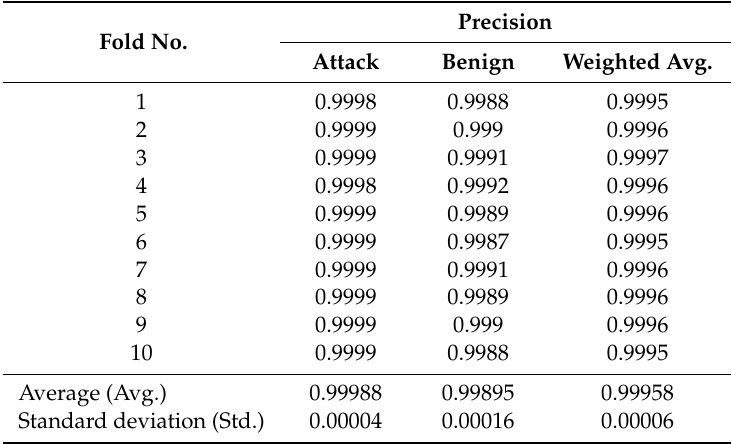
Table 5. Precision results of the 10-fold cross-validation for attack and benign classifications using the selected feature numbers.